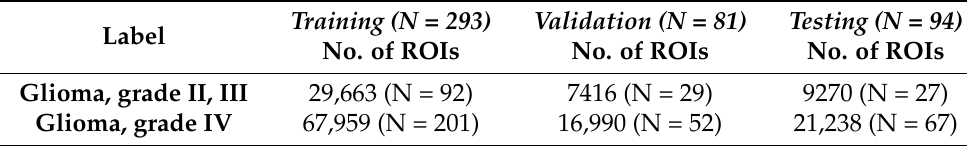
Table 3. The dataset for grading diffuse gliomas.